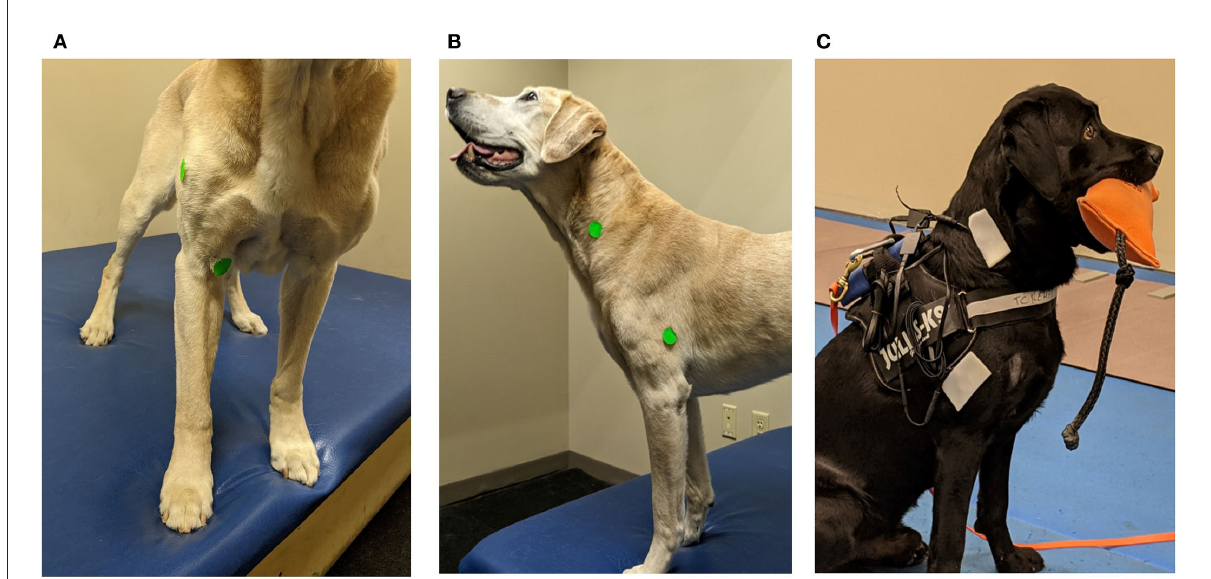
FIGURE1 Demonstration of the acoustic myography (AMG) sensor and recording unit placement. (A) Green stickers used to demonstrate the placement of sensors in the research dogs. The biceps brachii placed at 2/3 of humeral length and deltoideus acromial portion is placed mid-muscle belly. The dog is a demo dog and not used in the study. (B) Green stickers used to demonstrate the placement of sensors in the research dogs. The brachiocephalicus sensor placed at the 4th cervical vertebrae and the triceps long head sensor placed at ½ the length of the humerus. The dog is a demo dog and not used in the study. (C) AMG sensor placement with large stickers placed over the small sensors on a research subject. Picture demonstrating equipment set up with sensors placed over the triceps long head and the